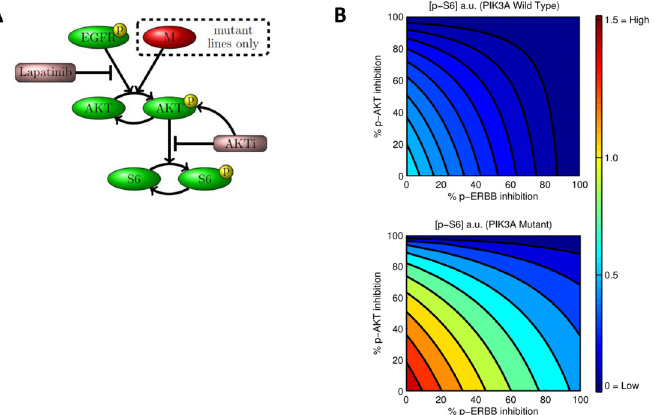
Fig 6. A . A simplified kinetic model for AKT pathway dynamics. Measured protein species (green; yellow circles indicate phosphorylation) are shown along with inhibitors (purple) and edges indicating regulatory interplay. An ERBB independent route to AKT activation is modeled as a node "M" (red) that can activate AKT in PIK3CA mutants only. To allow for the possibility that relevant player(s) were not observed in the RPPA data, the node was formally treated as an unobserved or latent variable. The edge from GSK690693 to p-AKT indicates that GSK690693 abrogates a negative feedback mechanism by which p-AKT regulates its own expression (possibly indirectly). All kinetic parameters were estimated using RPPA time-course data using a Bayesian statistical formulation. Note that links shown are not intended to represent direct influences but rather regulation via intermediate steps that are not explicitly modeled. B . AKT pathway activation (measured as equilibrium level of phospho-S6) as a function of the extent of ERBB (x-axis) and AKT inhibition (y-axis), as predicted by fitted model in A . In the wild type case (upper panel of B ), ERBB inhibition alone is sufficient to abrogate S6 phosphorylation. This is evident by the rapid downregulation of p-S6 with increasing concentrations of lapatinib, such that by the time 80% of ERBB activity is inhibited, there is almost complete inhibition of p-S6. In contrast, PIK3CA mutant lines (lower panel of B) , which have on average higher p-S6 baseline activity than their wild type counterparts, show diminished effects on p-S6 activity with increasing concentrations of lapatinib monotherapy. Indeed, even when ERBB is completely inhibited, there is residual p-S6 activity present. In order to achieve full inhibition of p-S6, combined inhibition of ERBB and AKT is required. For example, to achieve full inhibition of p-S6, the model predicts that inhibition of both ERBB and AKT activity by at least 80% is required in the mutant